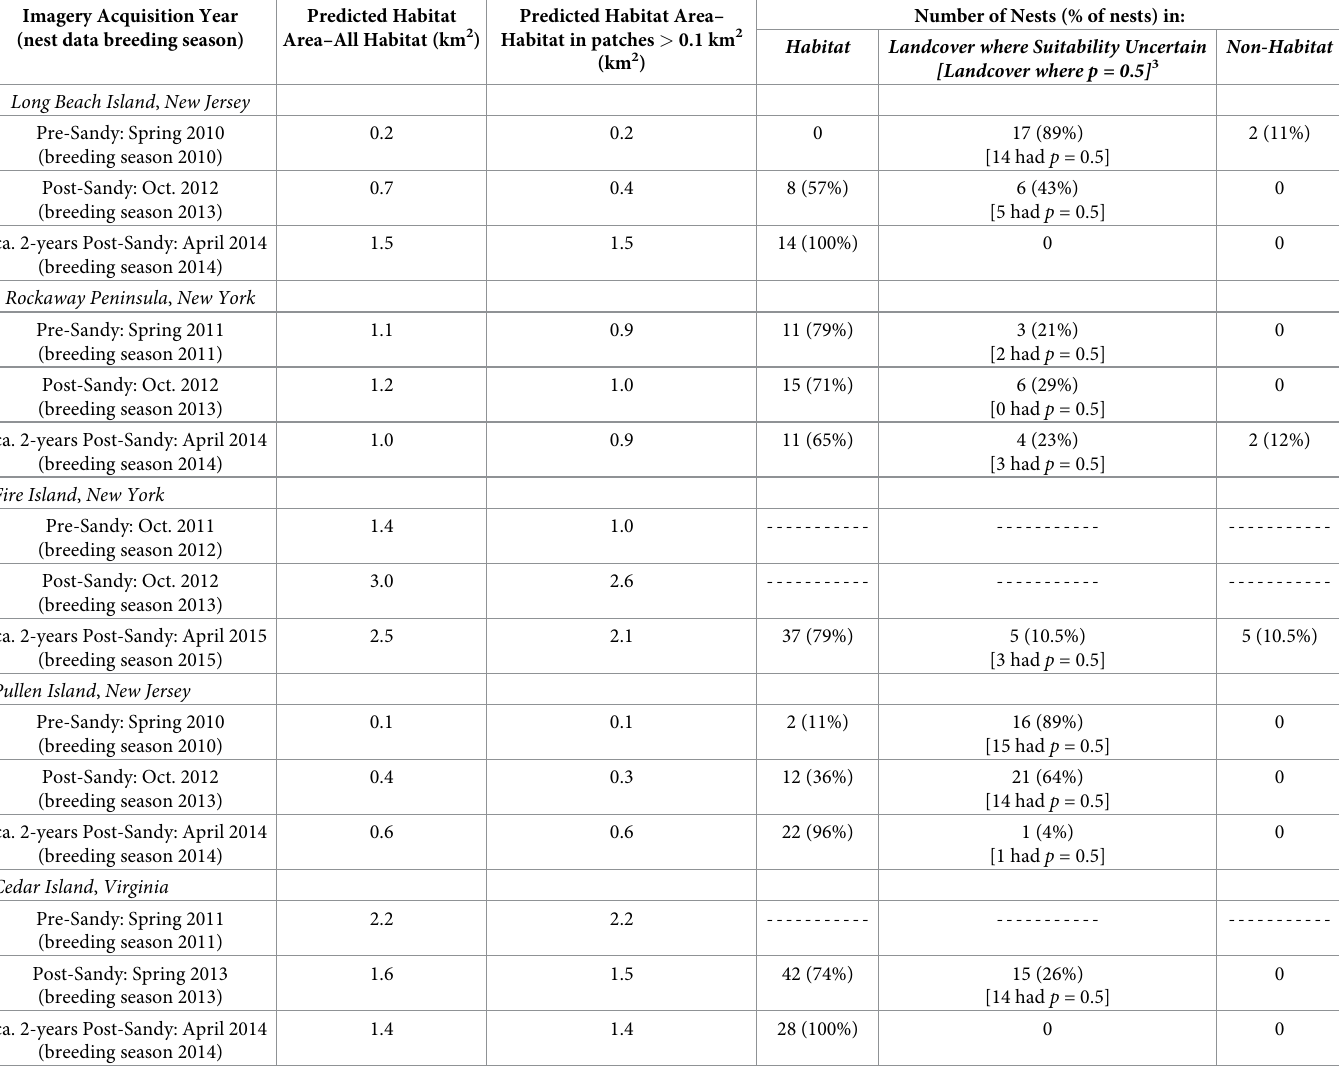
Table 2. Predicted habitat, according to the Plover Habitat Bayesian network 1 , for piping plover nesting before Hurricane Sandy, immediately following Sandy, and ca. 2 years post-Sandy at study areas in New York, New Jersey, and Virginia, USA. For reference, we indicate the number of nests 2 that were established in what the model predicted to be habitat, non-habitat, or uncertain landcover (where a suitability designation could not be made). Sites are listed in decreasing level of anthropo- genic development. Imagery Acquisition Year (nest data breeding